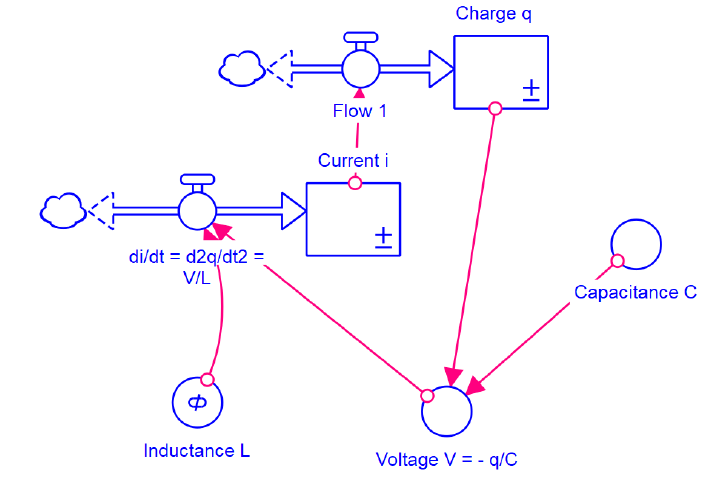
Fig. 22. LC circuit stock-and-flow diagram